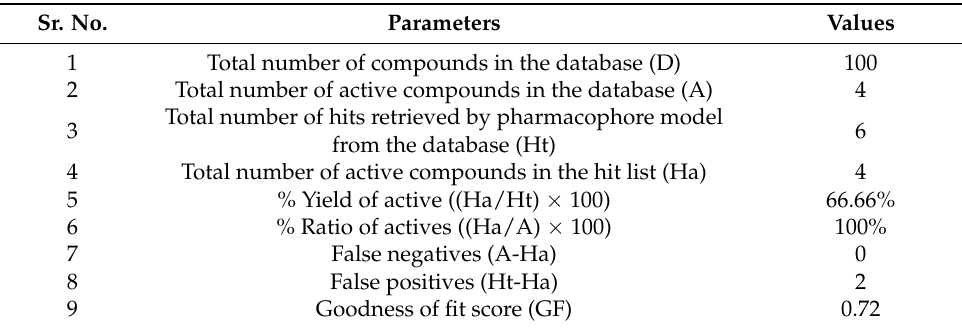
Table 2. Decoy set validation of Hypo1 from an external database composed of active and inactive Heparanase